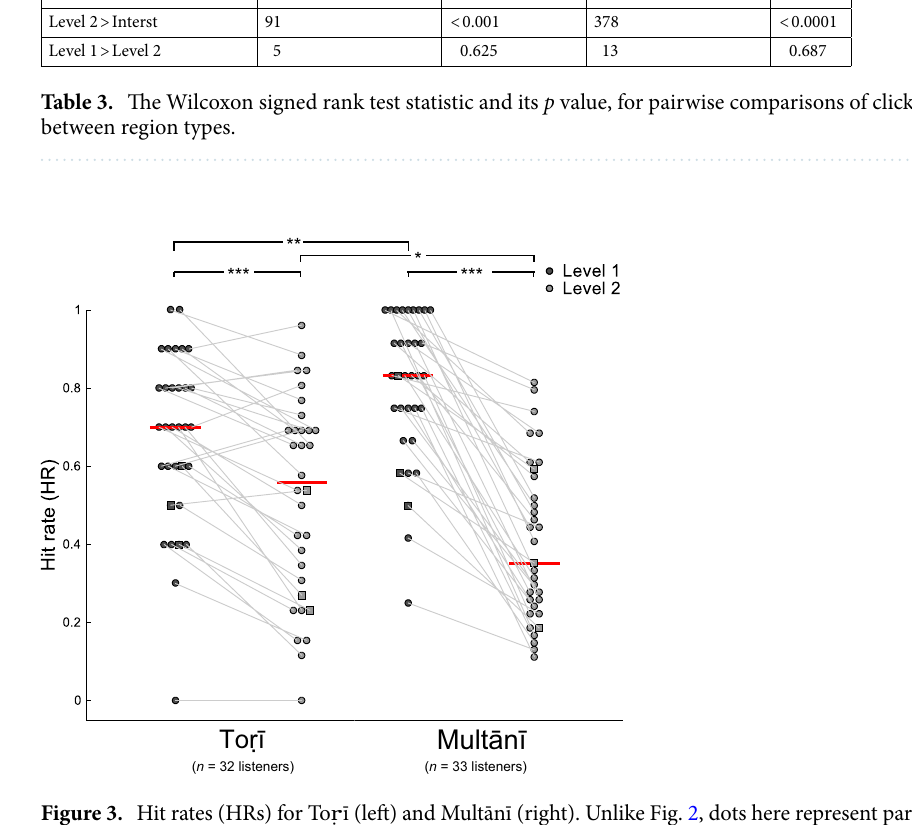
Figure 3. Hit rates (HRs) for To ṛ ī (left) and Multānī (right). Unlike Fig. 2, dots here represent participants, i.e. their HRs, for Level 1 (black) and Level 2 (grey) EDBRs, averaged across listenings, and connected for each participant by thin grey lines. Red horizontal lines represent each category’s median. Squares represent participants familiar with Indian music ( n = 3 in each